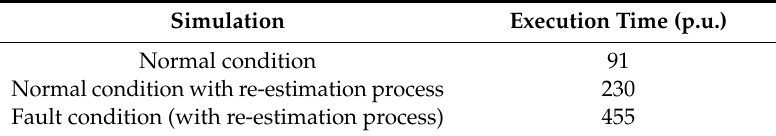
Table 5. Execution times for a real urban distribution system (Figure